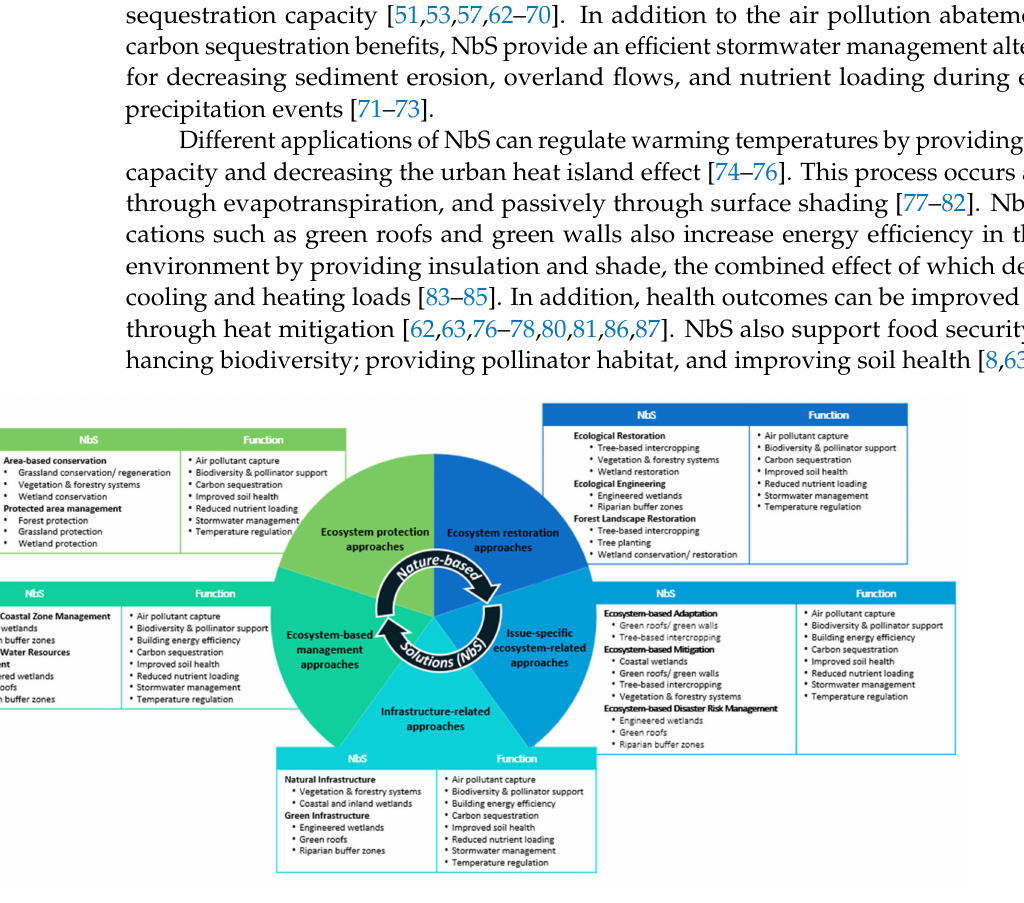
Figure 4. NbS categories and general examples established by the IUCN, are connected to a series of specific NbS and associated functions